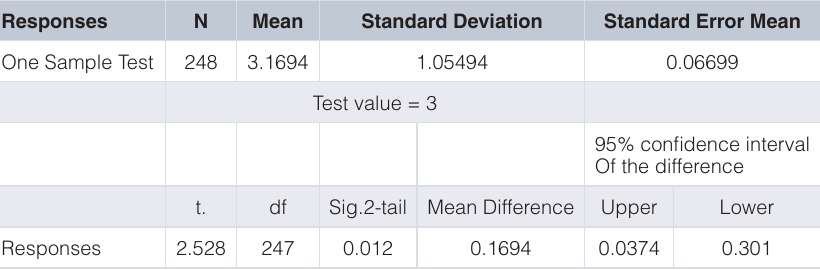
Table 3. Agricultural Extension Services of Edo Agricultural Development Programme (ADP) and crop